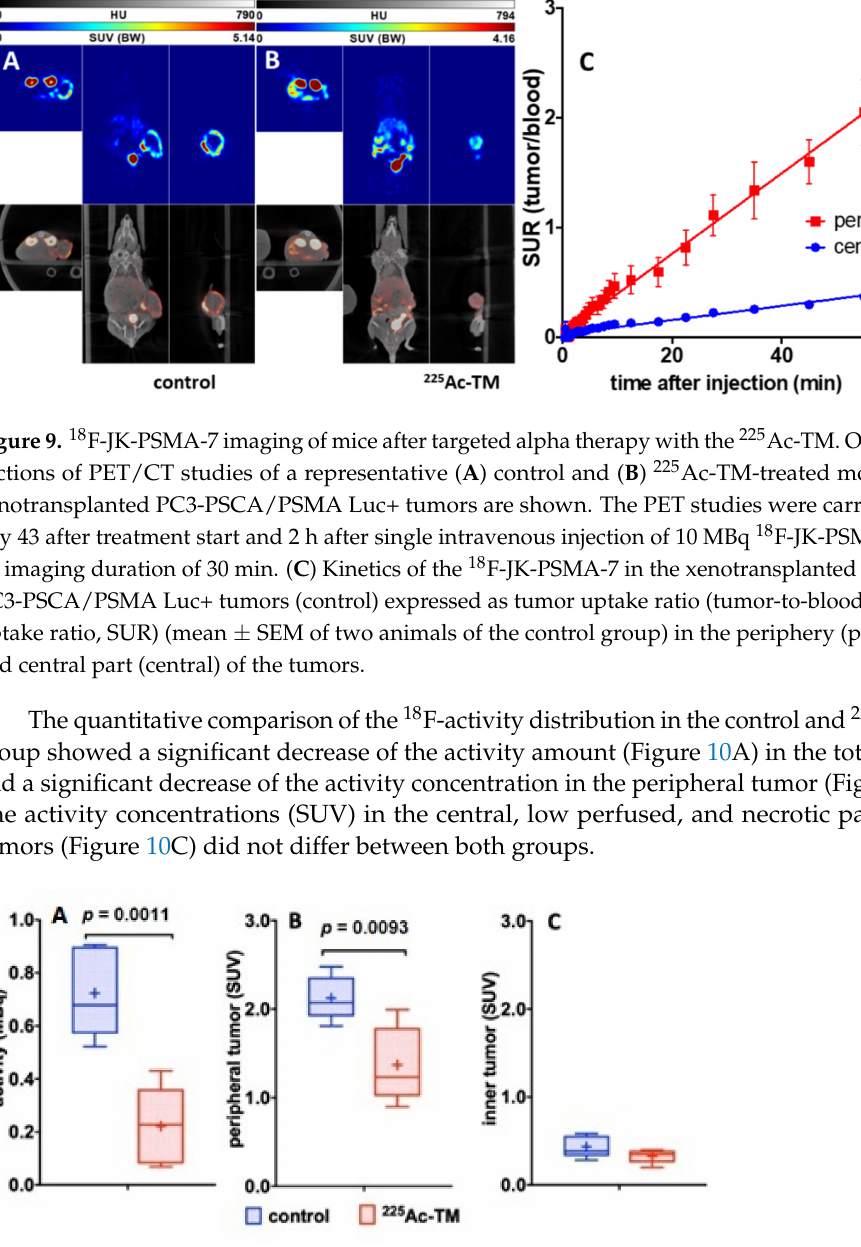
Figure 10. Quantitative comparison of the 18 F-JK-PSMA-7 activity distribution. ( A ) 18 F-JK-PSMA-7 activity amounts in the total tumor (MBq), ( B ) activity concentrations (SUV) in the periphery of the tumors, and ( C ) in the central part of the tumors are shown. The box and whiskers plots show mean SUV values for each group indicated as “+” in the control ( n = 4) and 225 Ac-TM treated group ( n =